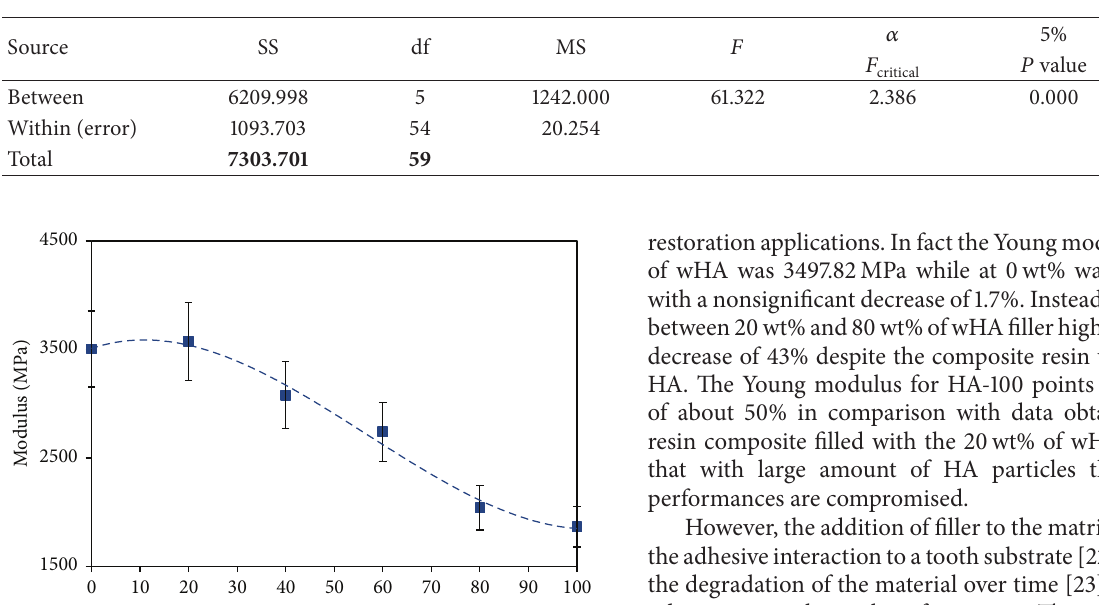
Table 3: Statistically significant differences on flexural strength values were evaluated by one-way ANOVA, 𝑃 < 0.05 .